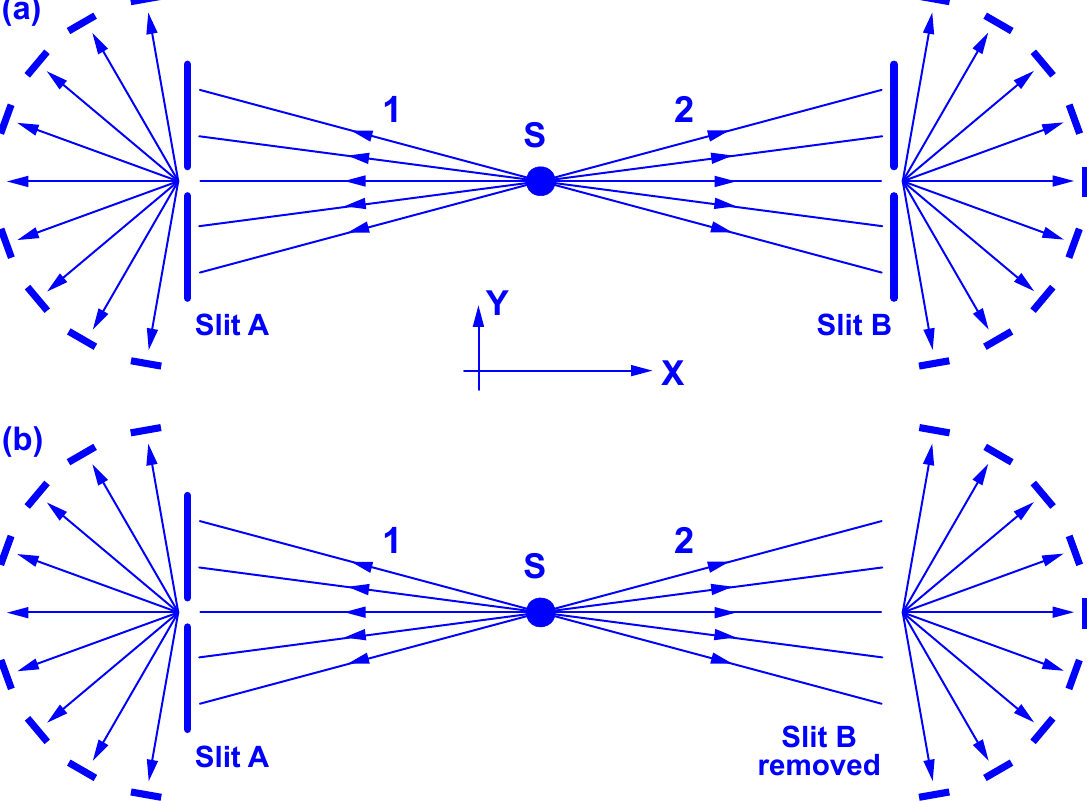
Figure 1: Schematic diagram of Popper’s thought experiment. (a) With both slits, the particles are expected to show scatter in momentum. (b) By removing slit B, Popper believed that the standard interpretation of quantum mechanics could be tested. way so as to conserve the initial momentum at the source, which is zero. There are two slits, one each in the paths of the two particles. Behind the slits are semicircular arrays of detectors which can detect the particles after they pass through the slits (see Figure